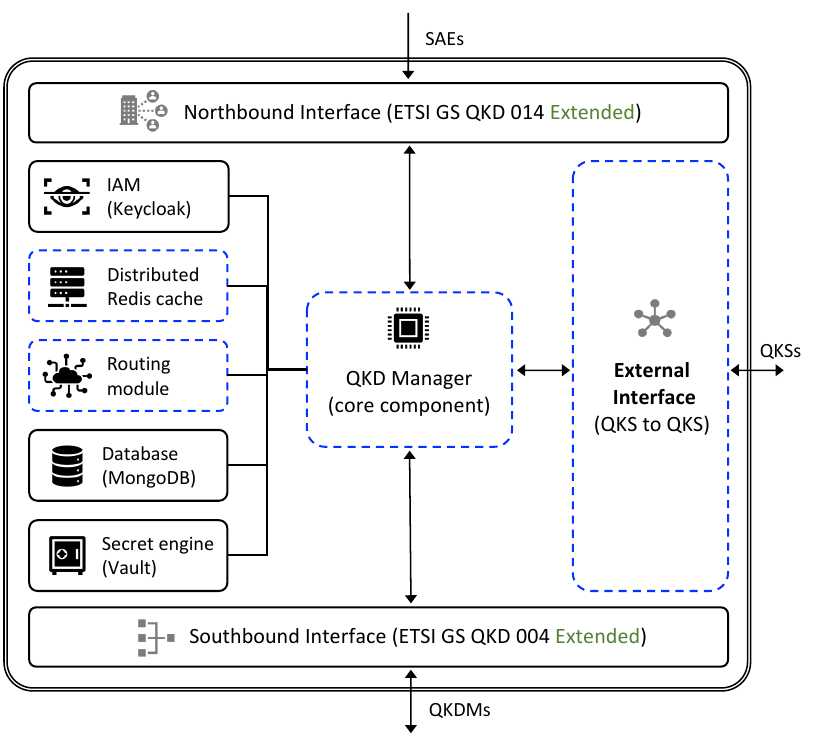
Figure 2. The architecture of the new Quantum Key Server (QKS)